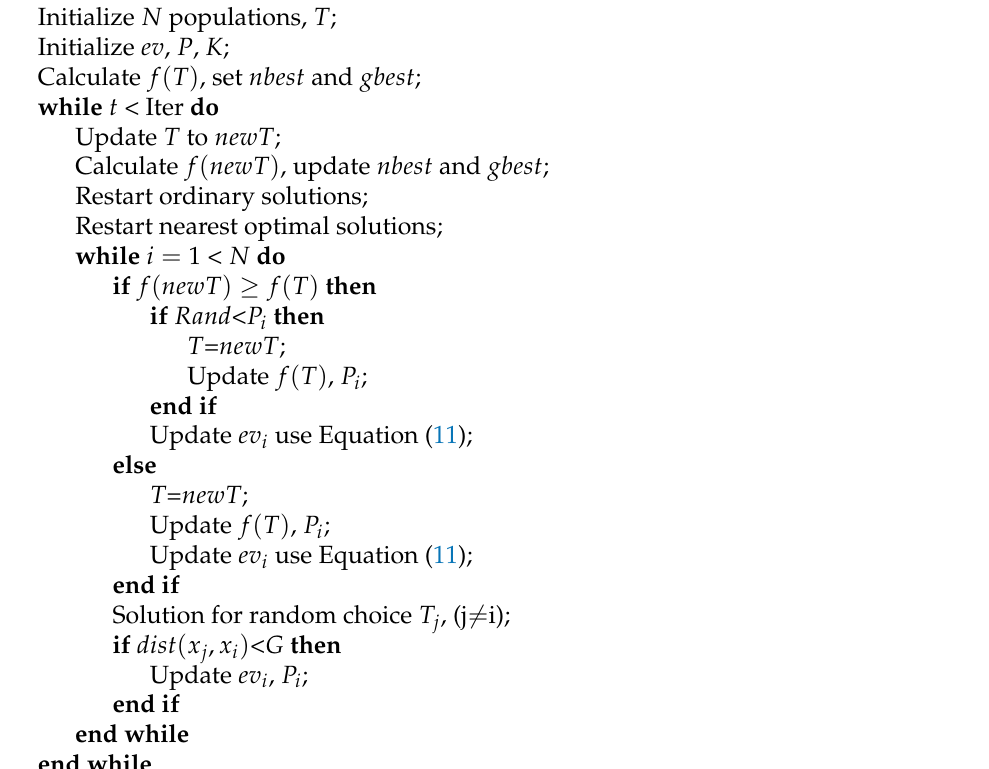
Algorithm 1 Advanced PPE